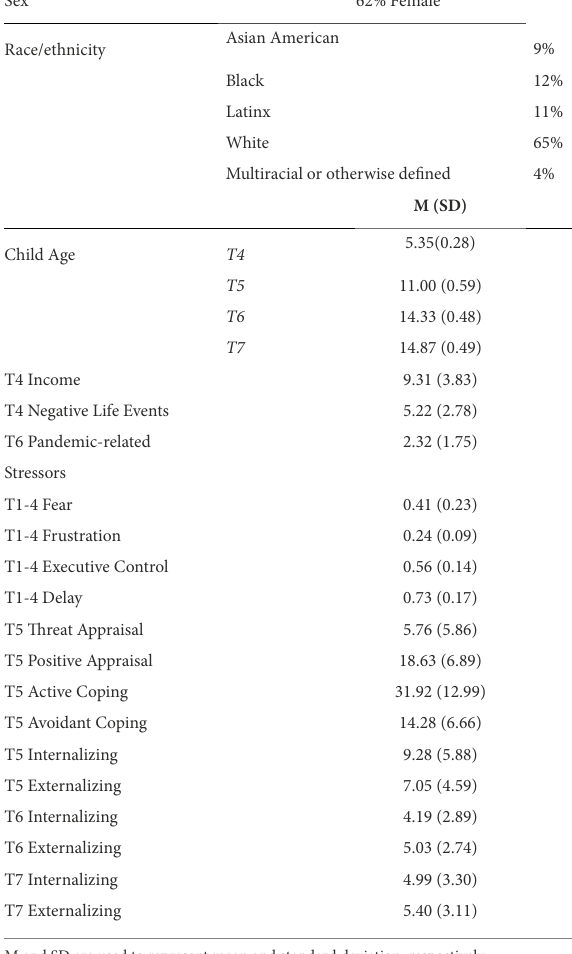
TABLE 1 Descriptive statistics for sample demographics and all study